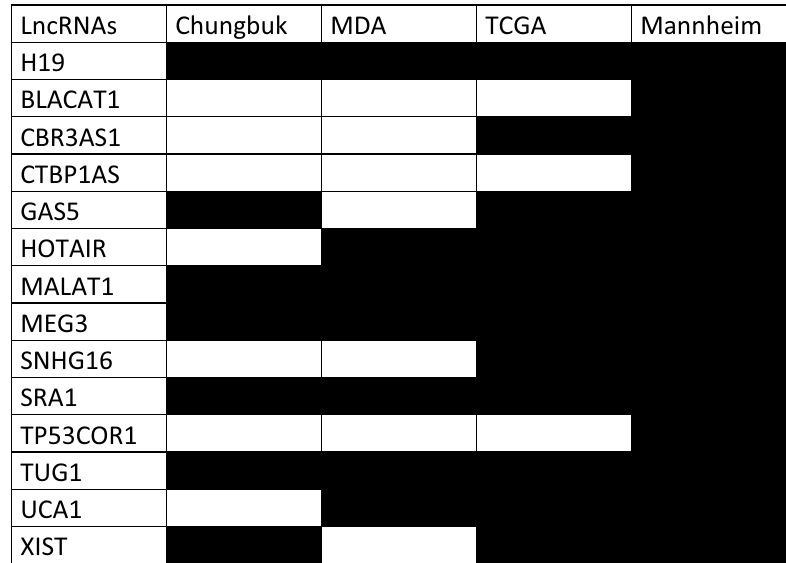
Table 1. Summary of available expression data of 14 pivotal lncRNA relevant in genitourinary cancers. Black = Expression data available.